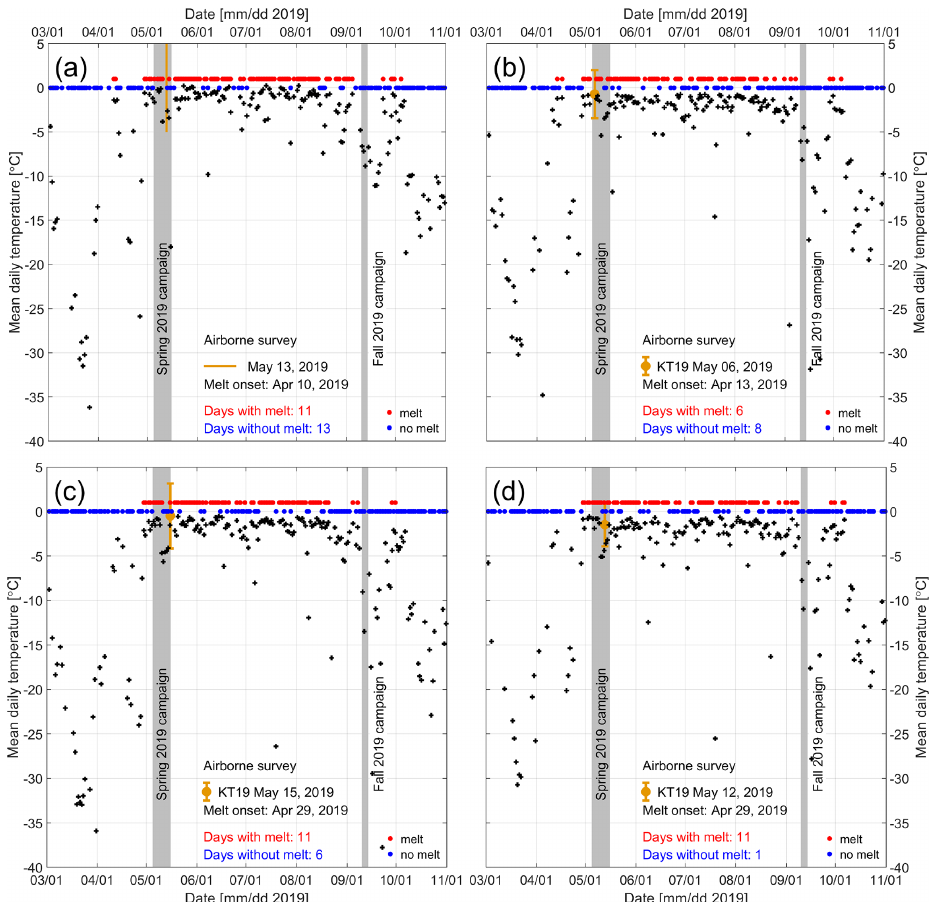
Figure A1. Surface temperature (black crosses) and surface melt indicator (red and blue circles) from MODIS (Hall et al., 2018; Hall and DiGirolamo, 2019) and mean ATM KT19 infrared surface temperatures (Studinger, 2019) averaged in 60s windows over the hydrological features with 1 σ standard deviation. The windows of operation of the spring and fall 2019 campaigns are indicated by vertical gray areas in all panels. Panel (a) show the times series for the approximate location of the oblique aerial photograph in Fig. 1, panel (b) is for the lake shown in Fig. 7, panel (c) is for the location of the lake shown in Fig. 8, and panel (d) is for the location of the streams and channels shown in Fig.